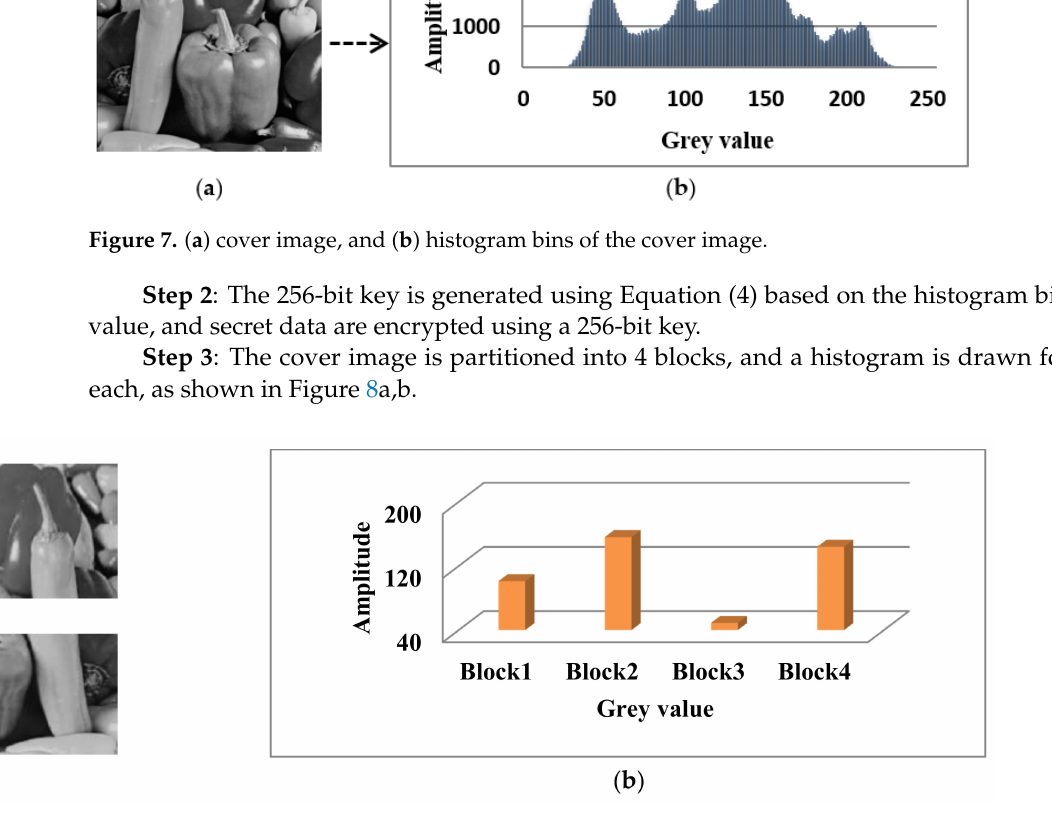
Figure 8. ( a ) Four blocks of the cover image, and ( b ) the histogram of each block. Step 4 : The contrast of each block is determined using Equation (1), and its contrast value is shown in Figure 9.